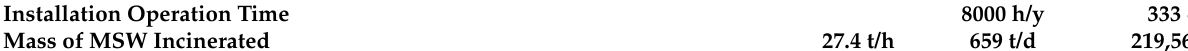
Table 1. Cracow MSW Incineration Plant. Material and energy input/output